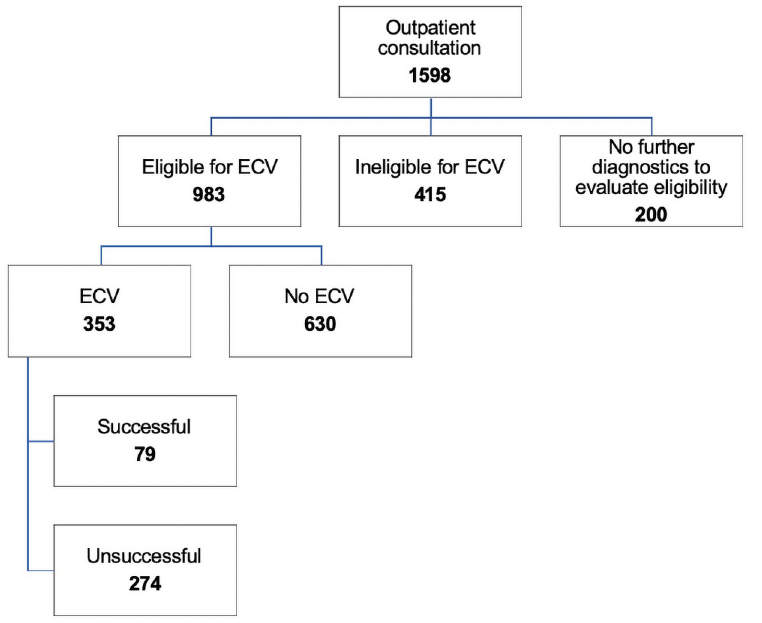
Fig 2. Flowchart of outpatient consultations for birth planning with breech